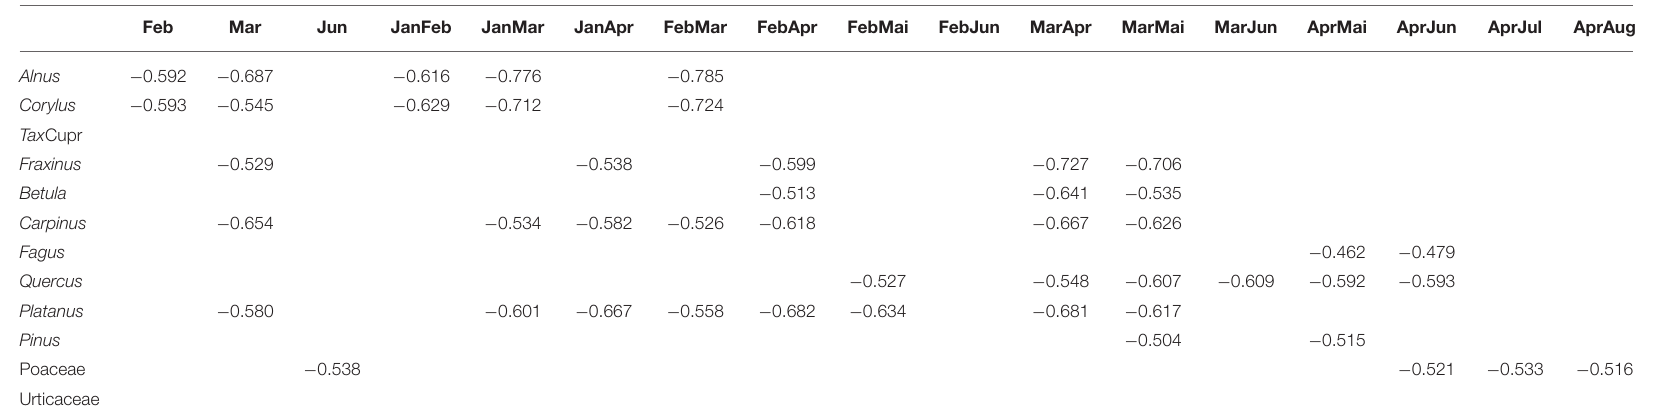
TABLE 6 | Correlation coefficients between temperature and end dates of the pollen